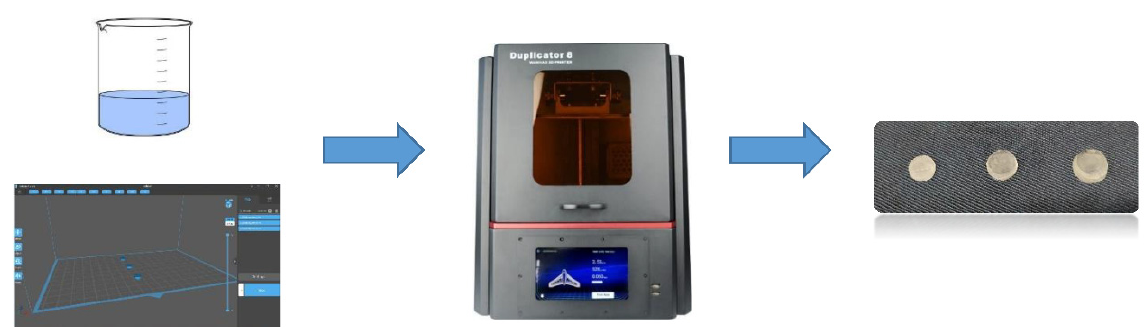
Figure 1. Schematic illustration of the DLP (digital light processing) printing process and obtained tablets of 1 mm, 2 mm and 3 mm thickness.